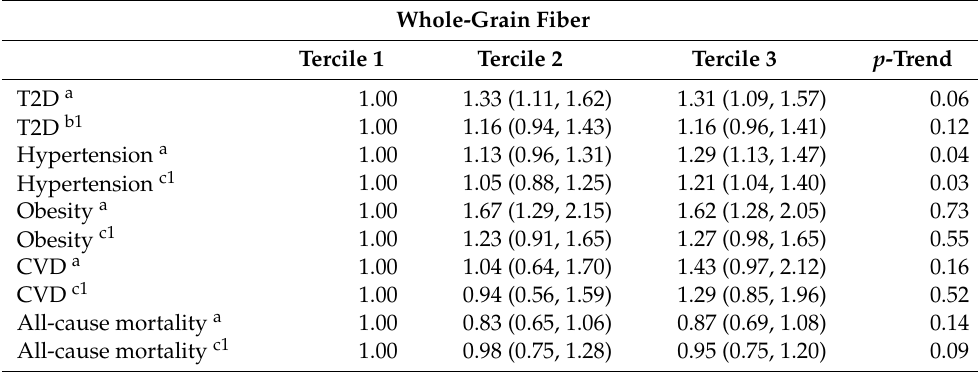
Table 3. Multi-variable adjusted HRs (95%CI) of T2D, hypertension, obesity, CVD, and all-cause mortality according to terciles of whole-grain fiber.